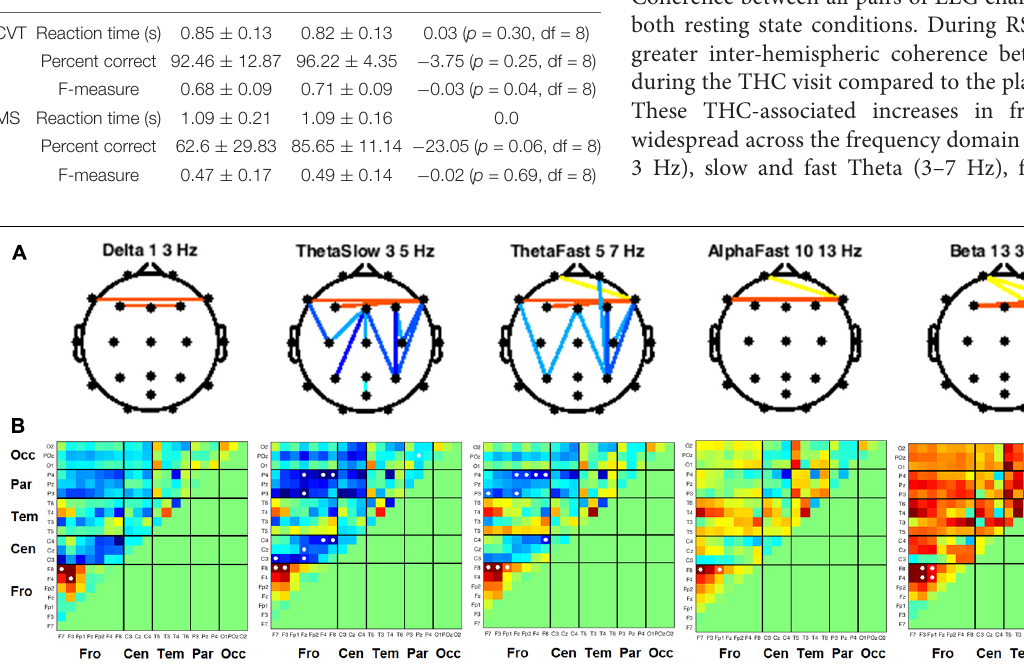
TABLE 5 | Reaction time (RT), percent correct, and F-measure for the 3CVT and VMS tasks, presented with means and standard deviations. Task Measure THC visit Placebo visit Difference 3CVT Reaction time (s) 0.85 ± 0.13